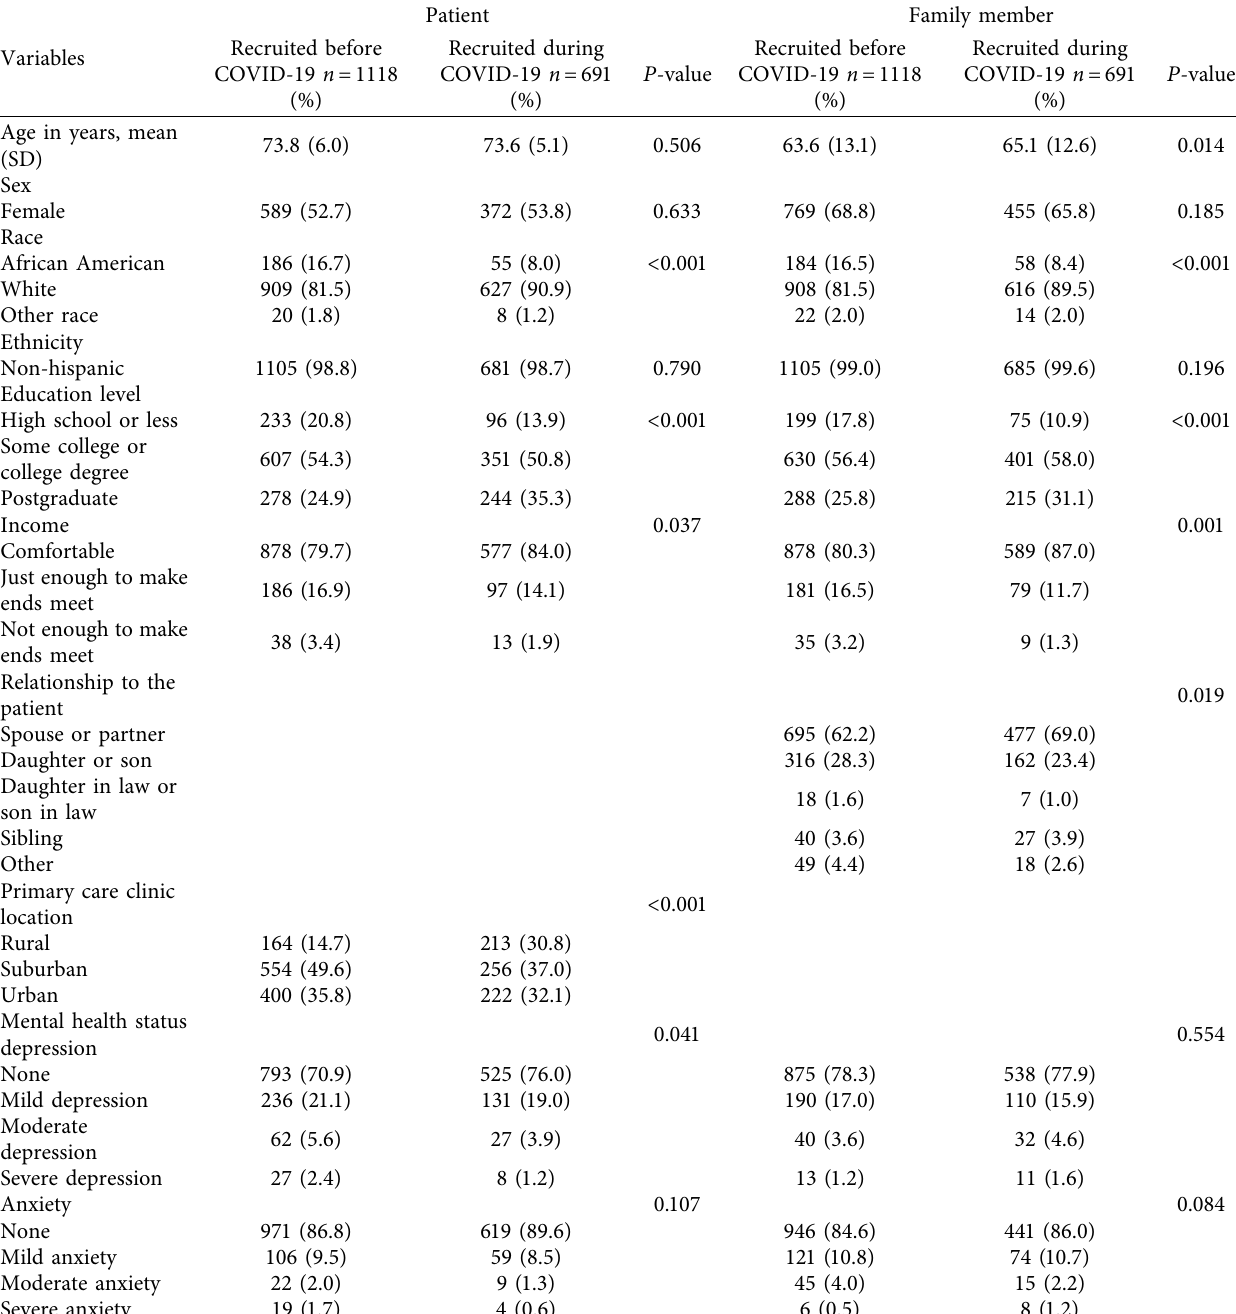
Table 1: Comparison of baseline